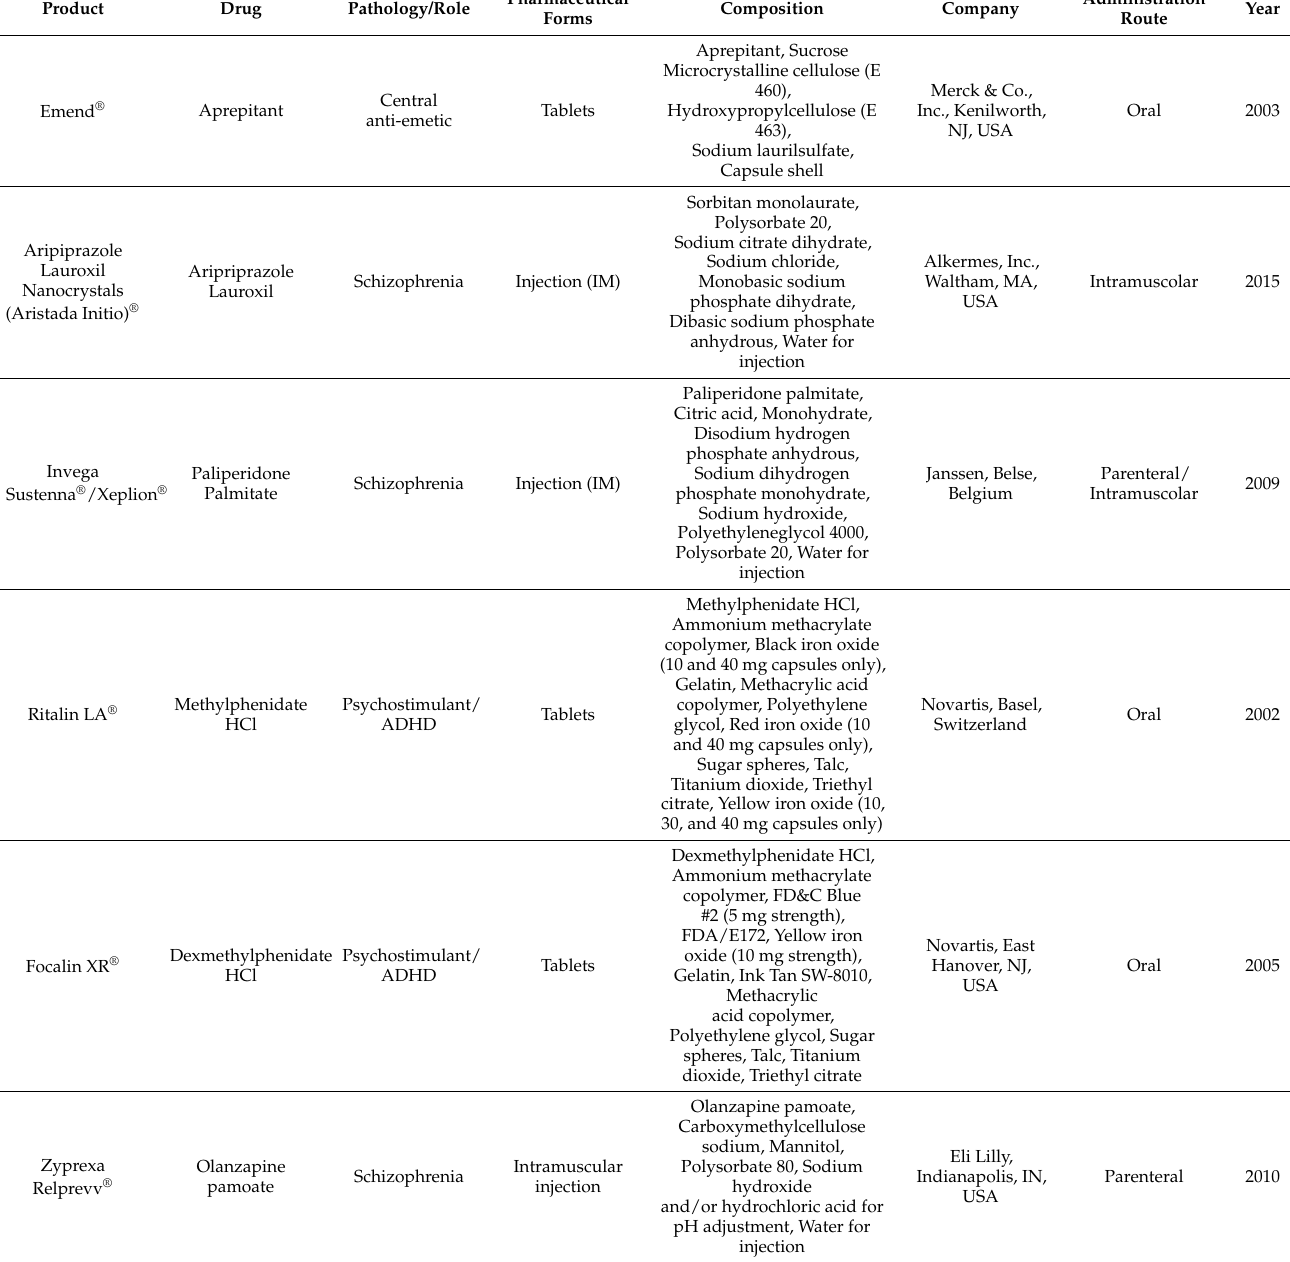
Table 3. Nanocrystal/nanosuspension-based products approved by the FDA for neurological